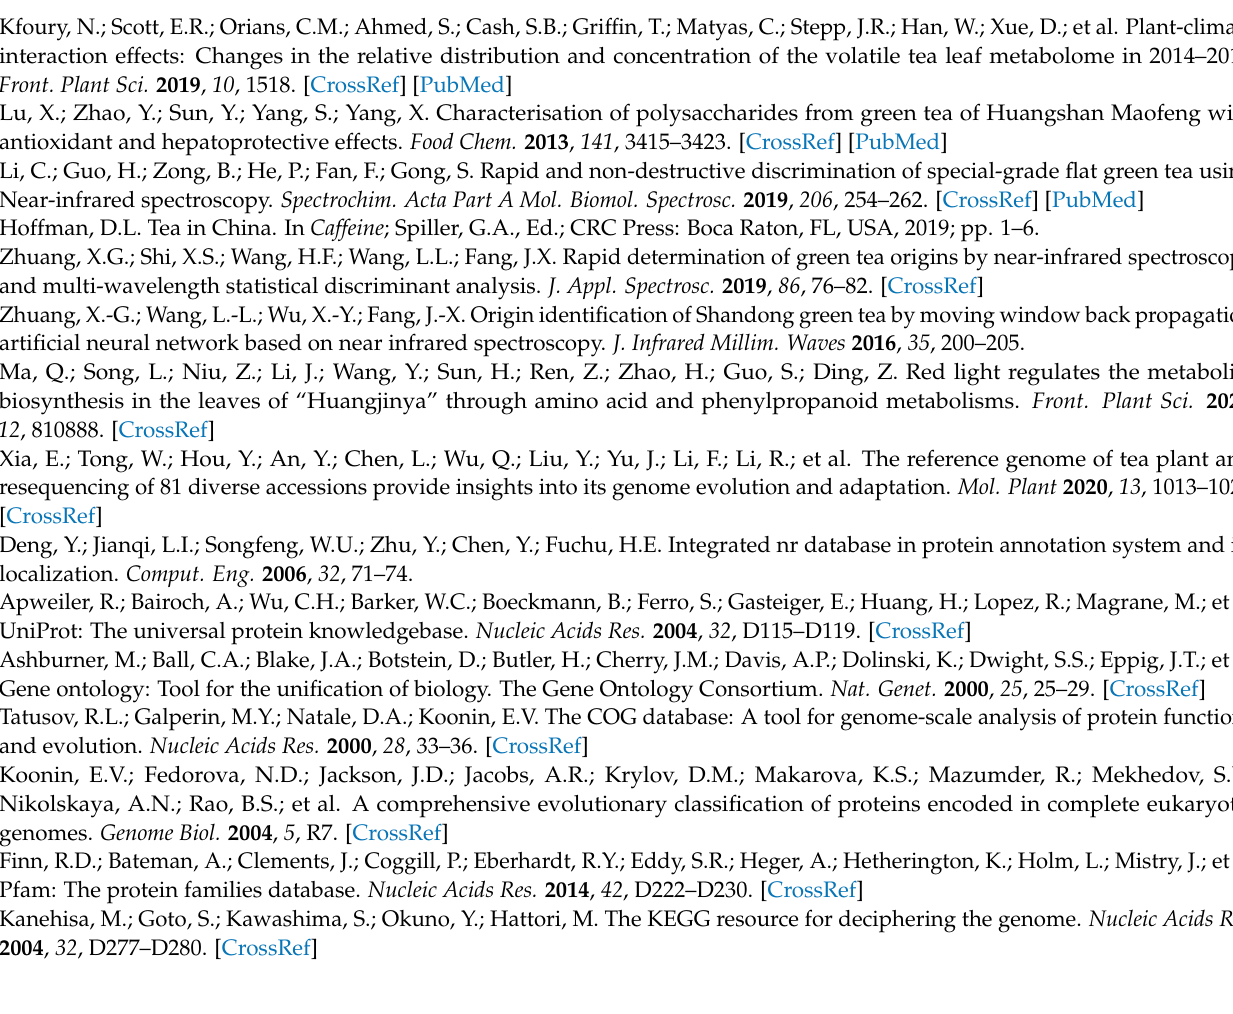
Table S2: The differential metabolites of Changqing tea in different seasons; Table S3: The common differential metabolites of Changqing tea in both tea gardens between different seasons; Figure S1: QRT-PCR verification of differential expressed